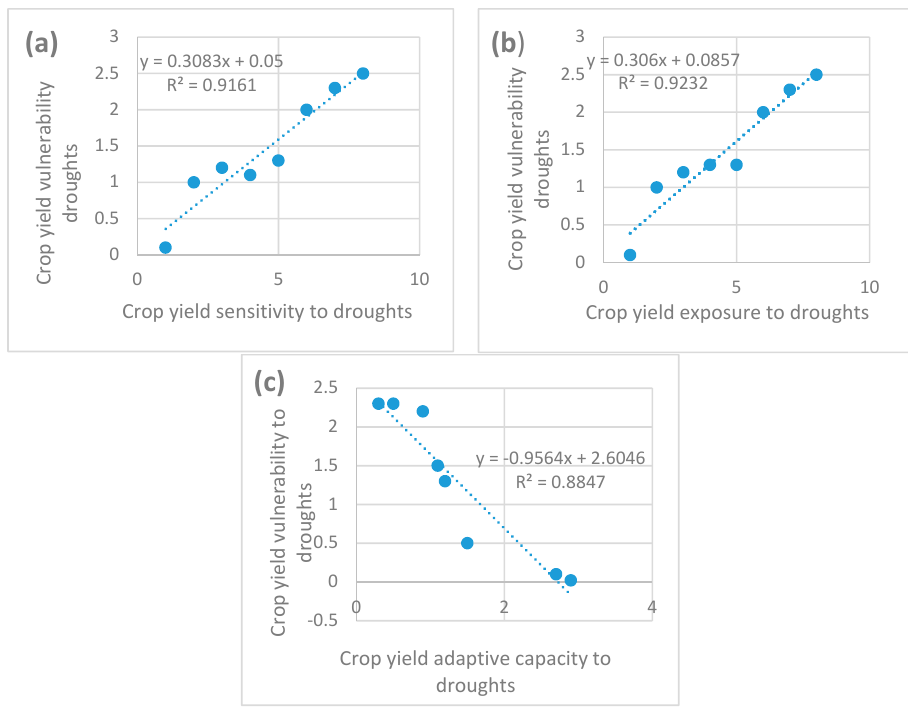
Figure 4. Relationship between crop yield vulnerability to droughts and ( a ) crop yield sensitivity to droughts, ( b ) crop yield exposure to droughts and ( c ) crop yields’ adaptive capacity to droughts.